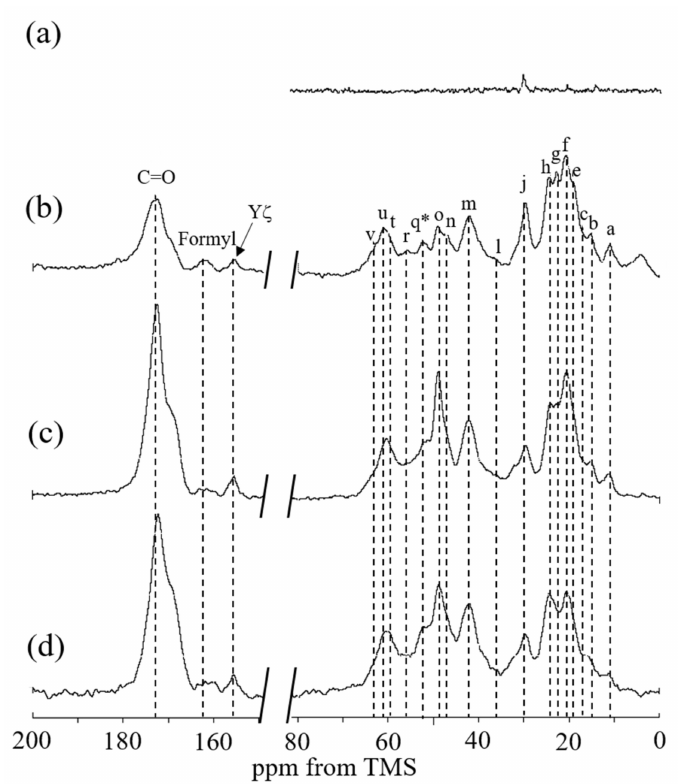
Figure 11. ( a ) 13 C r‑INEPT, ( b ) 13 C DD/MAS, and ( c ) 13 C CP/MAS NMR spectra of RSSP(VLI) fiber in the hydrated states and ( d ) 13 C CP/MAS NMR spectrum in the dry state. The peak assignment is shown in Figure 9. A peak at around 30 ppm in the spectrum ( a ) was assigned to